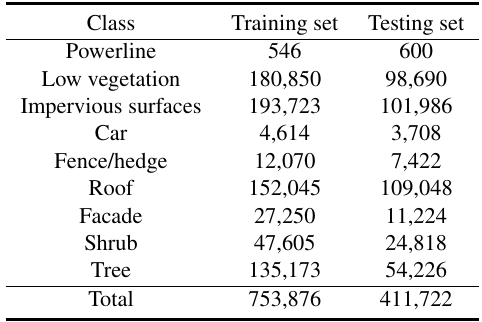
Table 1. Class distribution of ISPRS 3D dataset